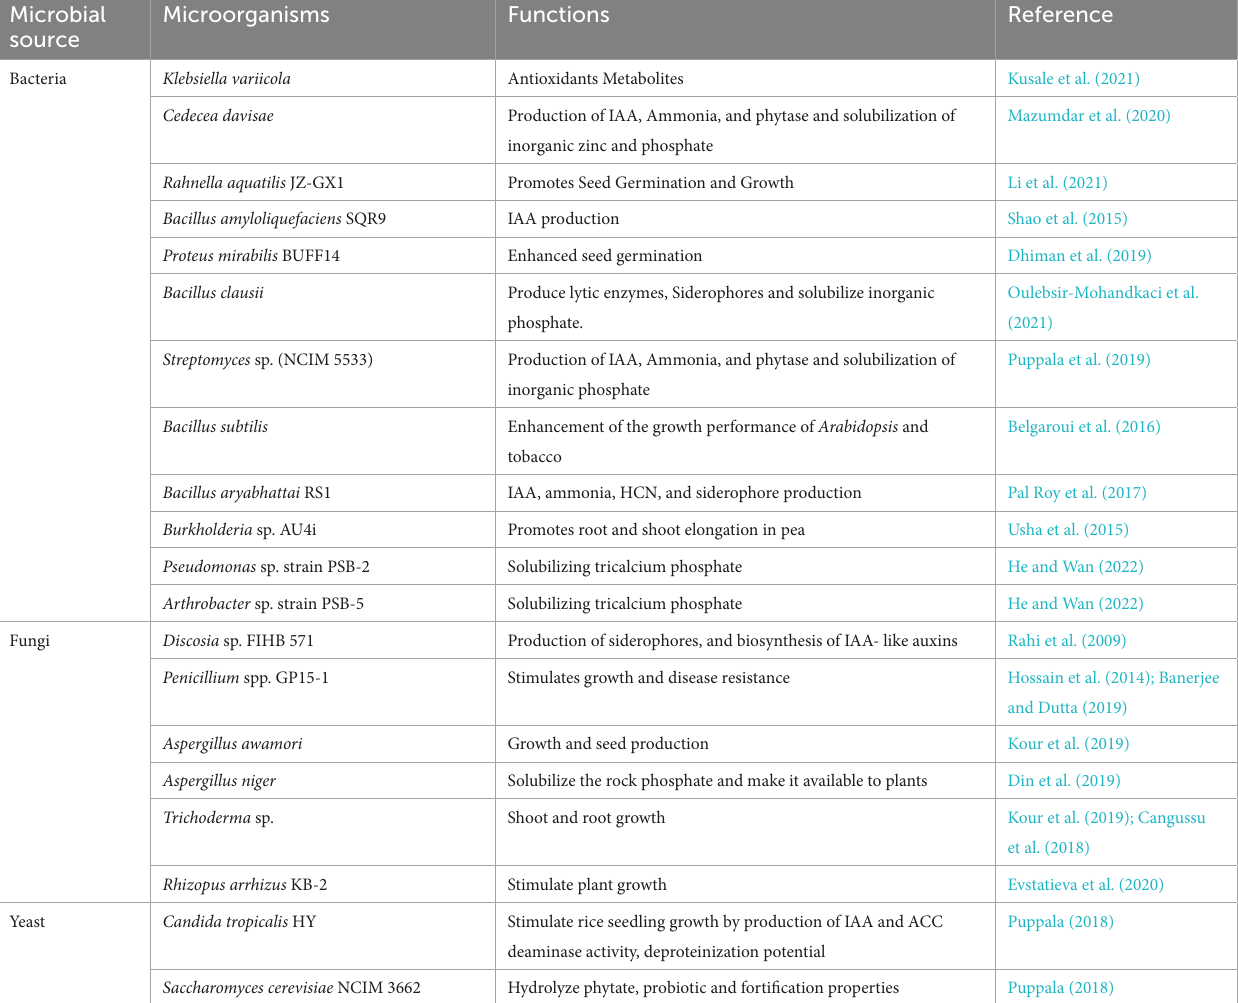
TABLE 1 Microorganisms producing phytase and having PGPR